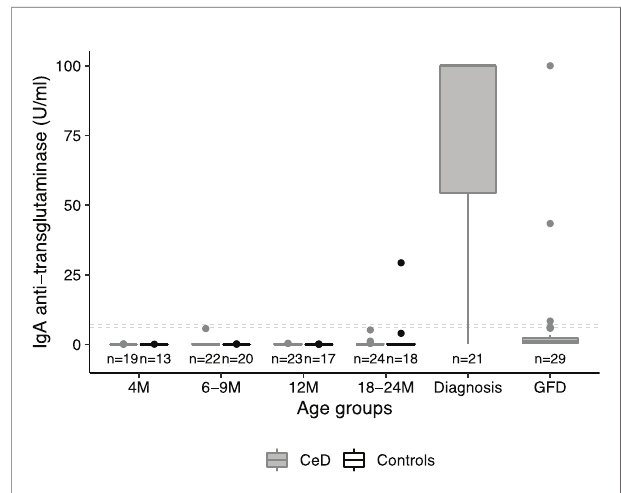
FIGURE 1 | IgA anti-transglutaminase levels peak at diagnosis in the patient group only. IgA anti-transglutaminase levels (TGA) in serum samples of PreventCD participants displayed by age of sampling (CeD=individuals who developed CeD; Ctr=age-matched samples of individuals who did not develop CD; M=Months). For the individuals that developed CeD, we also show serology at diagnosis and after initiating a gluten-free diet (GFD). Samples of individuals in the CeD group that were taken at timepoint of fi rst positive TGA (seroconversion) or at the time of the diagnostic biopsy, were grouped in the diagnosis group (age median: 24, range: 13 - 64 months). One control individual showed positive TGA (29 U/L), but this individual did not have or develop CeD in the follow up (see Supplemental Methods for more information). This sample with a positive TGA in the control taken at 3 years of age was grouped with the M18-M24 age group for visualization and analysis purposes. Dashed lines indicate the cutoffs used to assign positivity, depending on the two types of tests used (see Methods ). Boxplots were generated using the default parameters in the R package ggplot2 (median, second and third quartiles shown by the hinges, individual datapoints are displayed outside the whiskers beyond 1.5 * interquartile